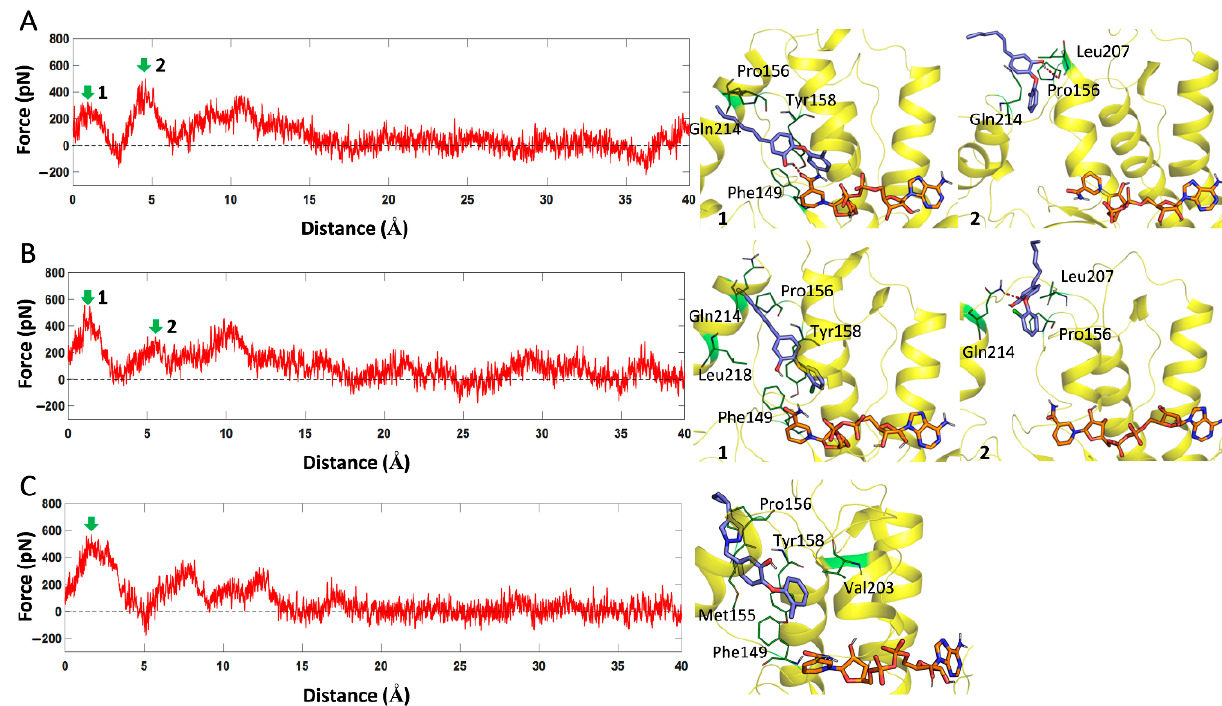
Figure 7. The force profiles of PT70 ( A ), PT91 ( B ) and PT501 ( C ) over the reaction coordinate along path1 channel. The structures at the maximum force (green arrow) were extracted and displayed on the right side of the picture. The number “1” corresponds to the first intermediate state in the dissociation process, and the number “2” corresponds to the second intermediate state.